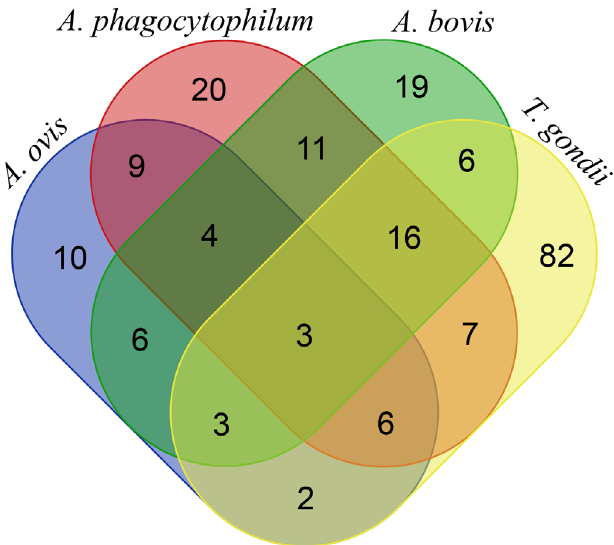
Figure 2. Venn diagram of mixed infection by T. gondii and Anaplasma in goats in Chongqing, southwest China. The number of goats tested positive for T. gondii and Anaplasma ( A. ovis , A. bovis and A. phagocytophilum ) infection is indicated by different colors in oval circles; the number of goats co-infected by pathogens is shown in the cross-over areas (n=